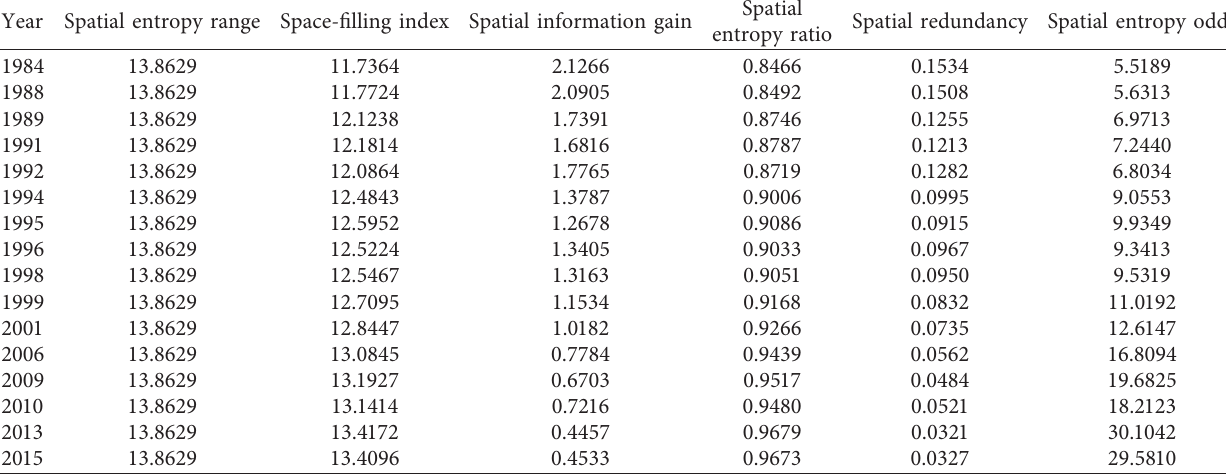
Table 4: Spatial measurements based on the Hartley entropy of Beijing’s urban form (1984–2015).